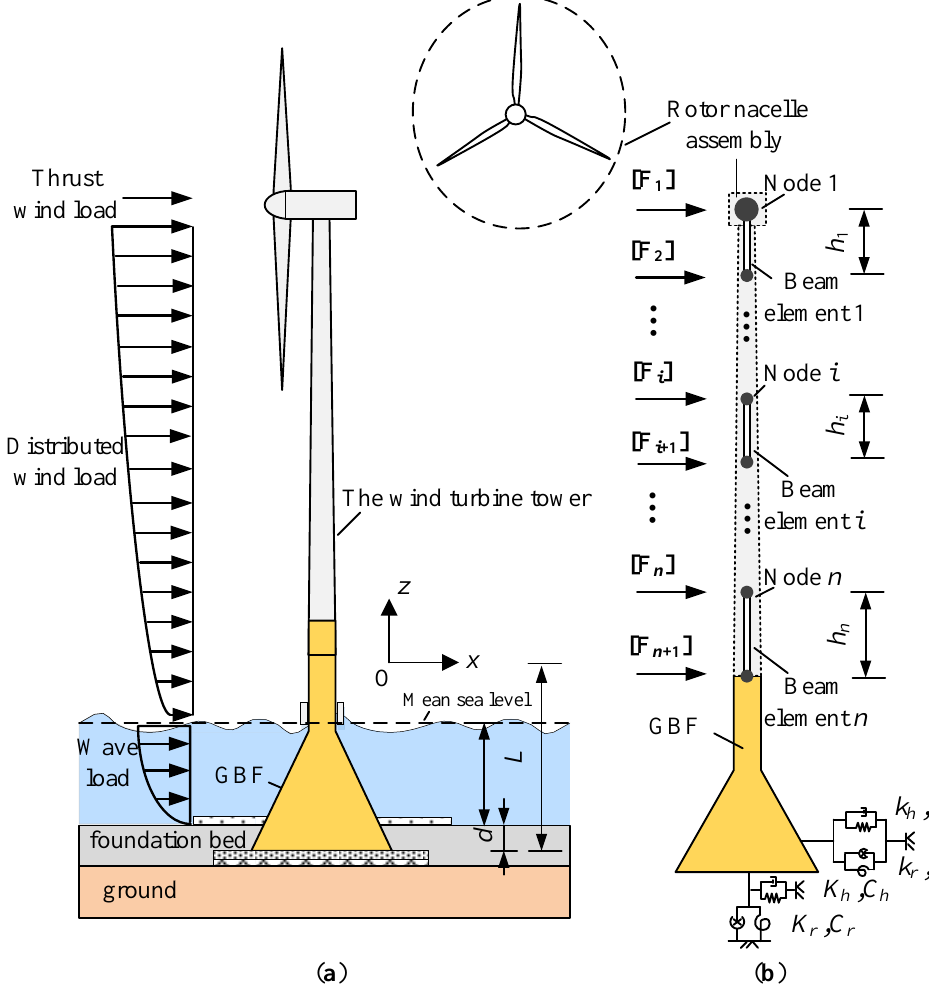
Figure 3. Dynamic analysis of the OWT on the GBF: ( a ) loads on the OWTs; ( b ) simplified analysis model.